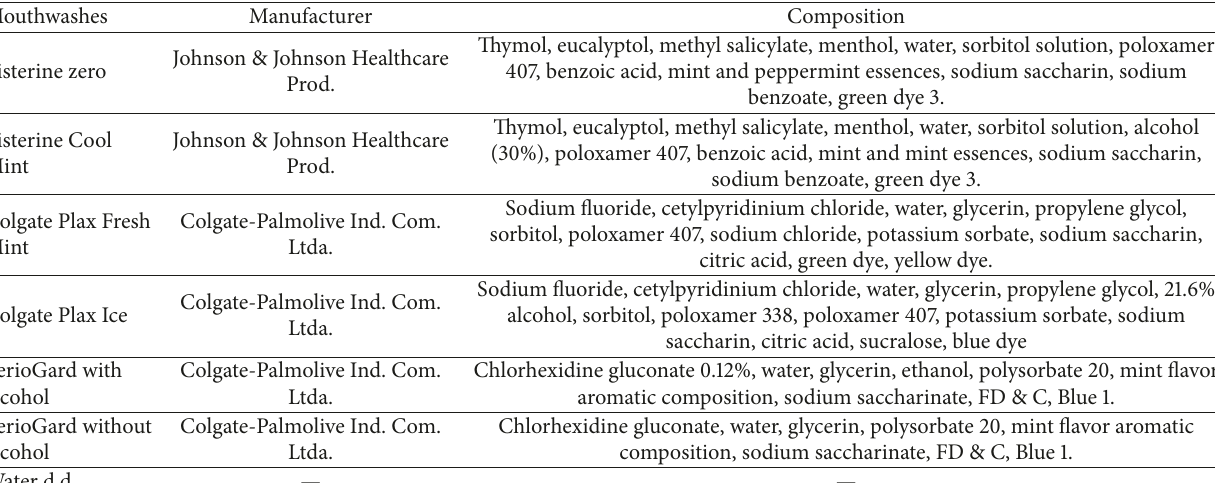
Table 2: Composition of Mouthwashes used in this study.